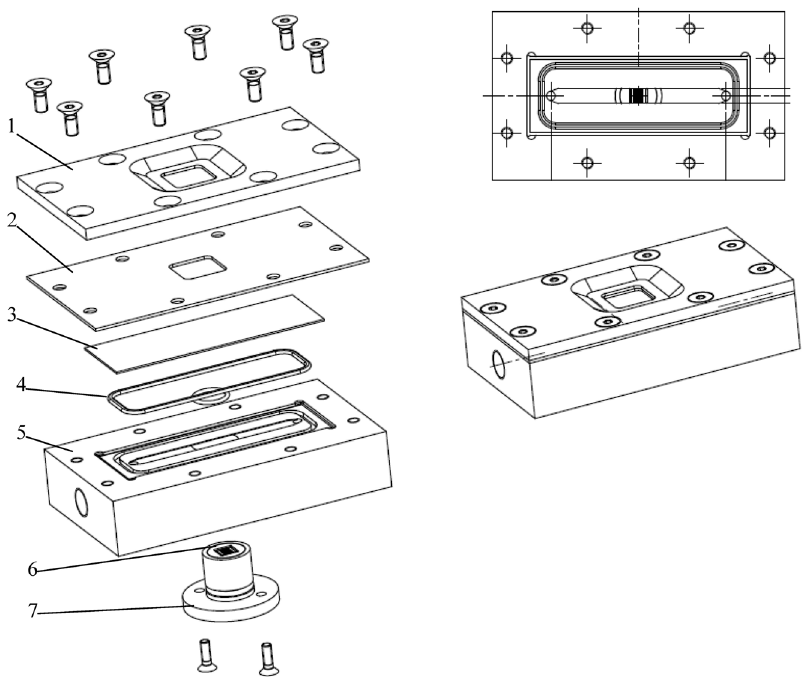
Figure 9. Schematic diagrams of the direct observation filtration chamber (1: cover; 2: joint; 3: glass coverslip; 4: O ring; 5: base; 6: microsieve; 7: disc